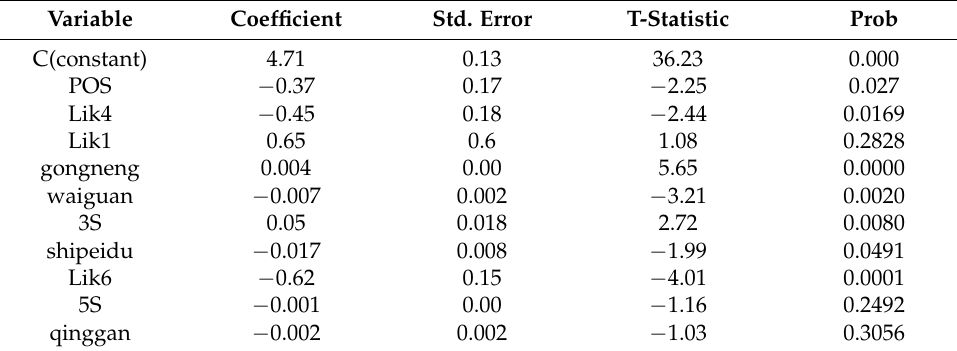
Table 13. Step by step backward regression results.